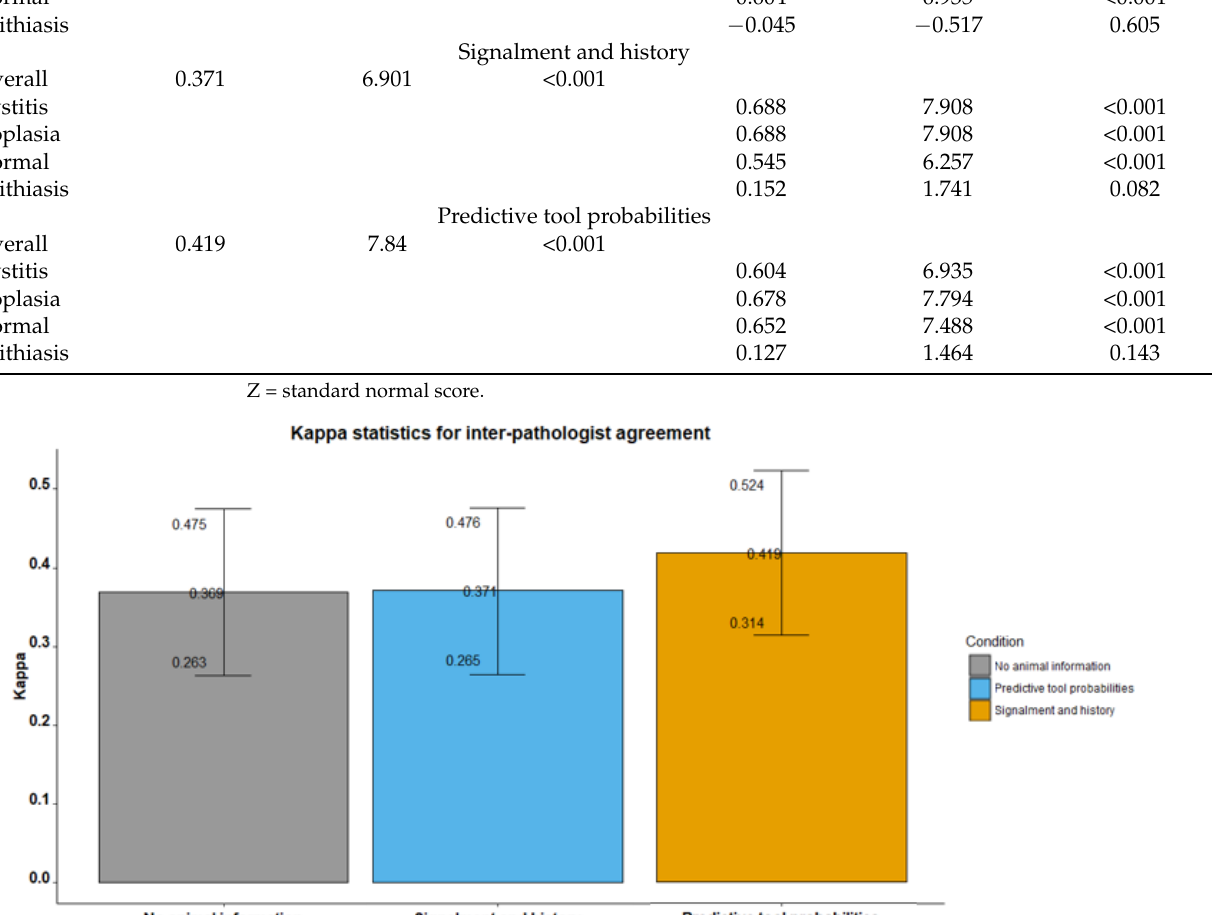
Table 6. Inter-pathologist agreement for the three slide-reading conditions, diagnosing glass slides of canine and feline bladder tissue.